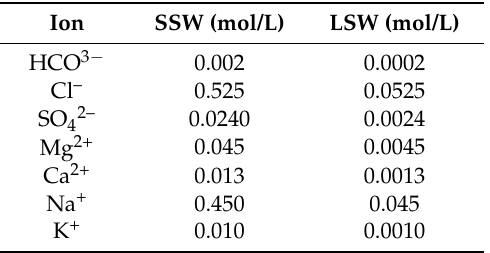
Table 2. Ion concentration in the brines.